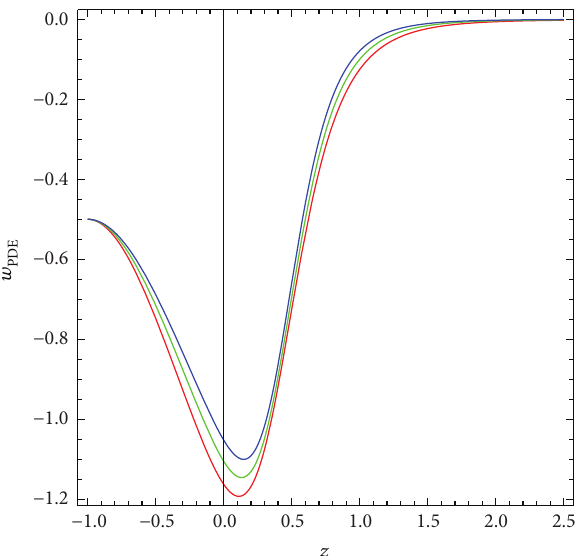
matter in the end. This type of behavior of EoS parameter is termed as quintom. Figure 4 ( 𝑢 = −2 ) shows similar behavior We plot the above EoS parameter versus redshift parameter 𝑧 for PDE parameter 𝑢 = 2, −2 as shown in Figures 3 and of EoS parameter as in case of 𝑢 = 2 . It is concluded that both PDE 𝑓(𝐺) models favor the PDE 4, respectively, while keeping the other constants same as in previous section. We use the expression of scale factor −1 . It can be in terms of redshift parameter 𝑎 = 𝑎 0 (1 + 𝑧) observed from Figure 3 ( 𝑢 = 2 ) that the EoS parameter starts from quintessence phase (at the present time), crosses the phantom divide line, and then goes towards phantom phase of the universe. After achieving the extreme value of phantom phase, the EoS parameter turns back and approaches dust like